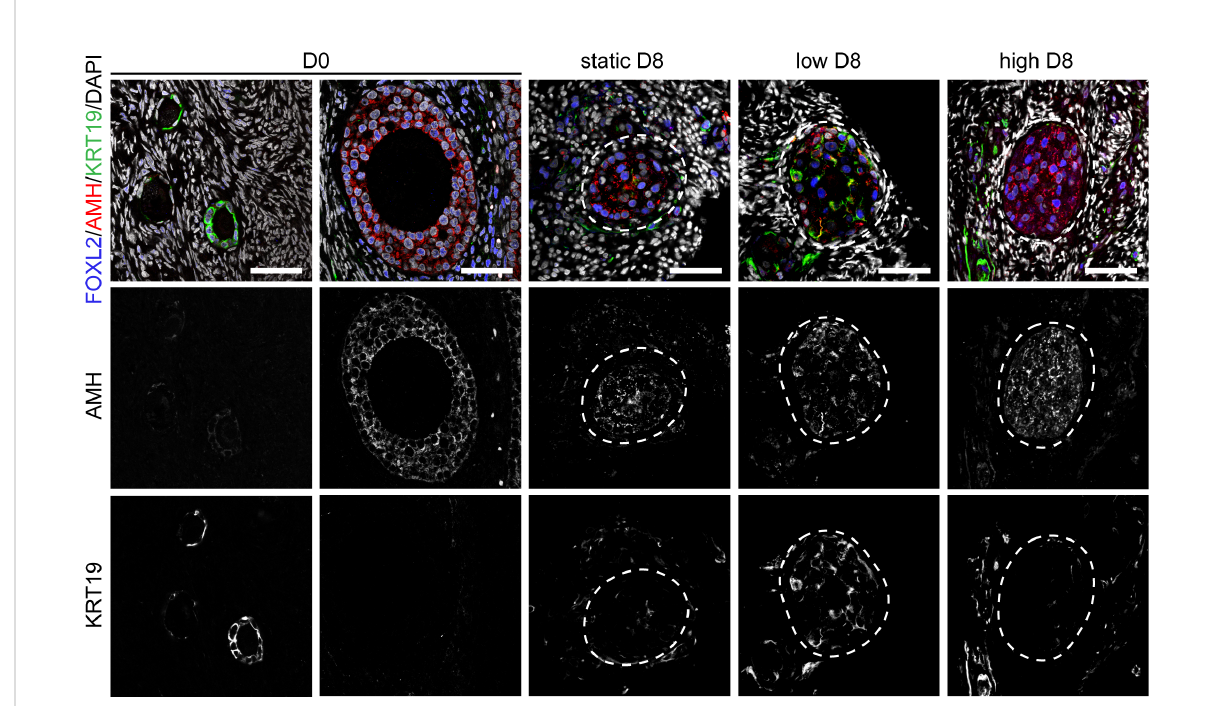
FIGURE 4 Expression of FOXL2, AMH and KRT19 in secondary follicles after culture. Immuno fl uorescence for FOXL2, AMH and KRT19 in primordial, primary and secondary follicles at D0 and after eight days (D8) culture in static, low and high fl ow rate. Scale bars = 50 m